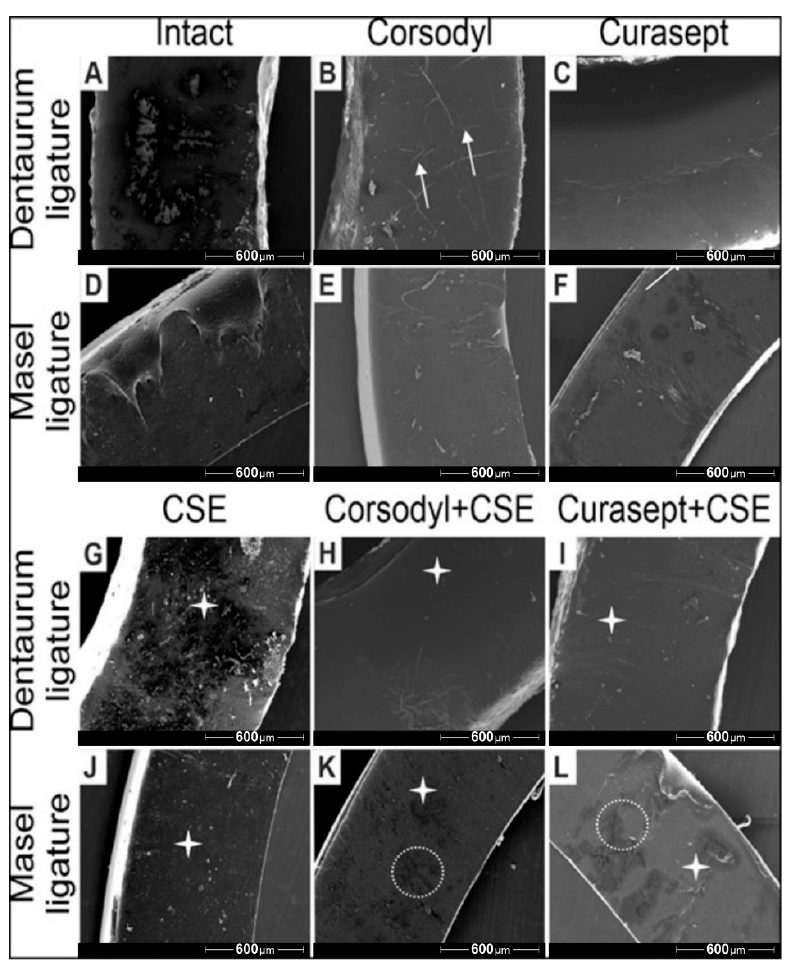
Figure 7. Representative scanning electron microscopy images of Dentarum and Masel ligatures 8 weeks after exposure to ( A , D ) artificial saliva (control ligatures), ( B , E ) Corsodyl, ( C , F ) Curaspet, ( G , J ) cigarette smoke, ( H , K ) Corsodyl and cigarette smoke, ( I , L ) Curasept and cigarette smoke. White arrows represent the microlesions, the white stars mark smoke particles, and the dotted lines indicate the major cracks on the surface of Masel ligatures. 80× magnification.